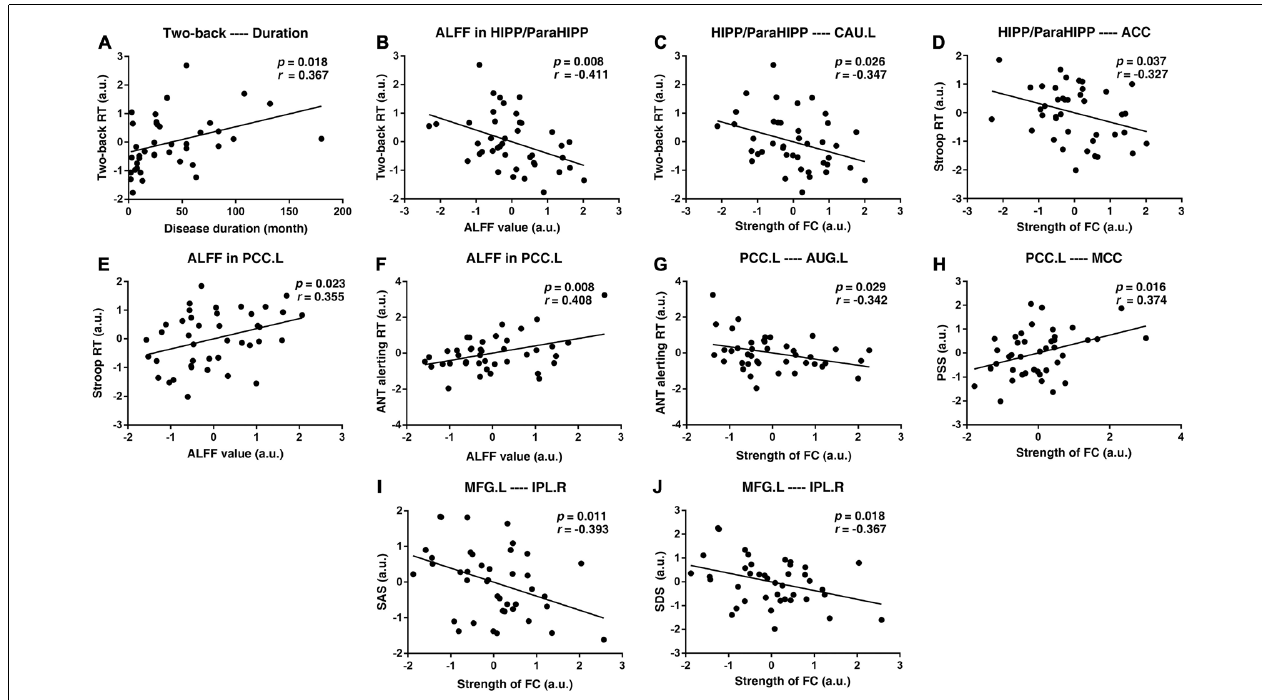
FIGURE 5 | Scatter diagrams showing the significant correlations between aberrant ALFF values, FC strengths, clinical data, and neuropsychological assessments of patients with UC. (A) Disease duration was positively correlated with the two-back reaction time (RT). (B,C) The two-back RT was negatively correlated with the decreased ALFF value of the HIPP/ParaHIPP and negatively correlated with increased FC strength between the HIPP/ParaHIPP and CAU.L. (D,E) The RT of the Stroop test was positively correlated with the increased ALFF value of the left posterior cingulate cortex (PCC.L) and negatively correlated with increased FC strength between the HIPP/ParaHIPP and anterior cingulate cortex (ACC). (F,G) The alerting effect of the attention network task (ANT) was positively correlated with the ALFF value of the PCC and negatively correlated with increased FC strength between the PCC.L and AUG.L. (H) The perceived stress scale (PSS) score was positively correlated with increased FC strength between the PCC.L and middle cingulate cortex (MCC). (I,J) The increased FC strength between the MFG.L and IPL.R was negatively correlated with the self-rating anxiety scale (SAS) and self-rating depression scale (SDS)